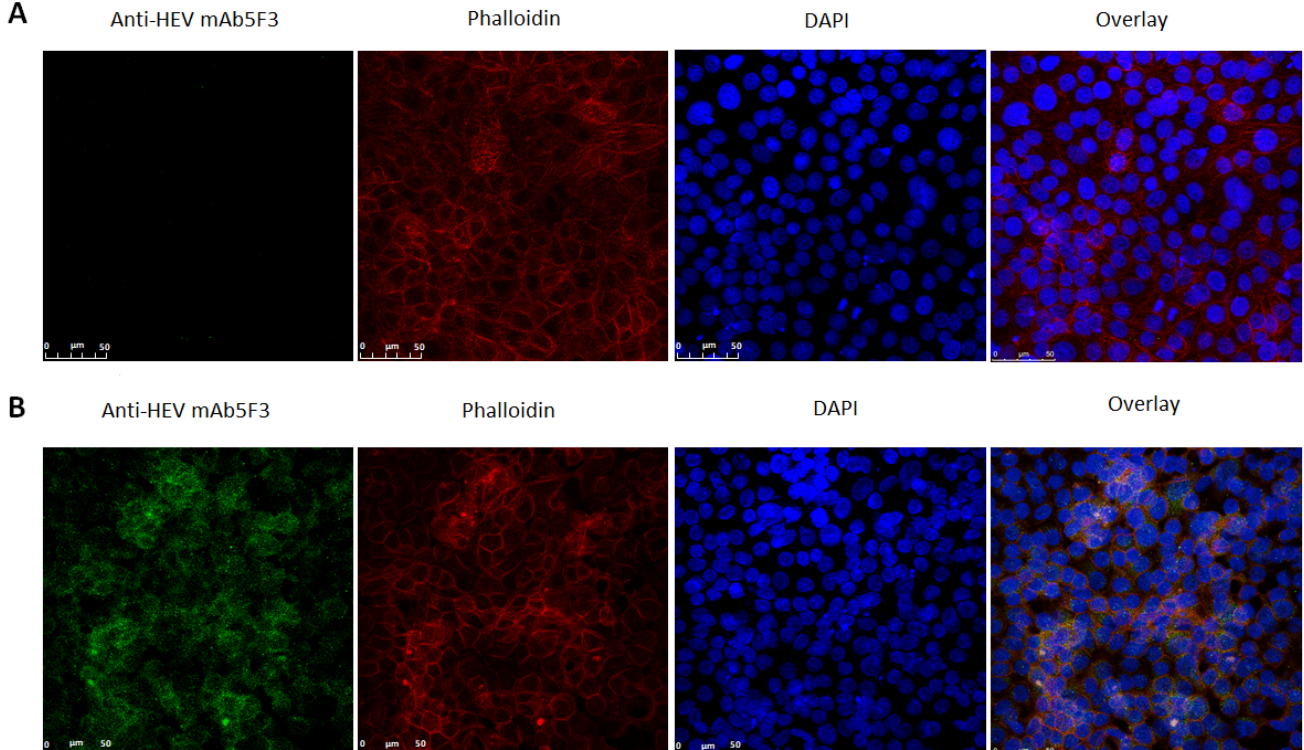
Figure 3. Confocal microscopy panels of uninfected ( A ) and HEV-infected ( B ) MARC-145 cells. mAb 5F3 (Alexa Fluor 488; green) were used for HEV capsid protein staining, phalloidin (red) for cytoskeletal staining and DAPI (blue) for cell nuclei staining. Scale bar: 50 μ m.